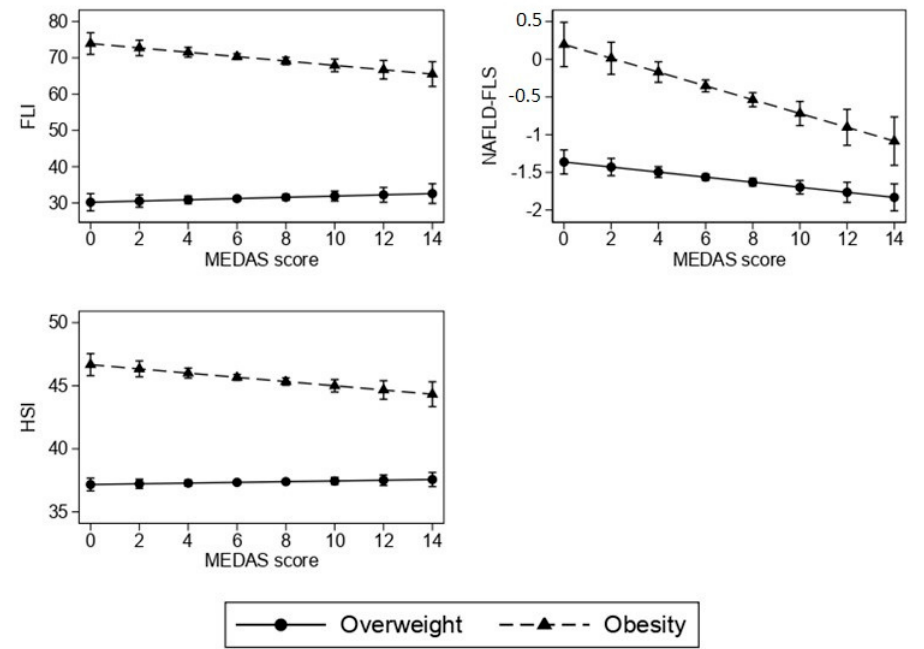
Figure 1. Association of Mediterranean diet (MEDAS score) with indices of fatty liver according to BMI category. Values are marginal means and 95% confidence intervals estimated from multivariable linear regression. Table 3. Association of Mediterranean diet with fatty liver indices in women affected by overweight and obesity according to menopausal status.